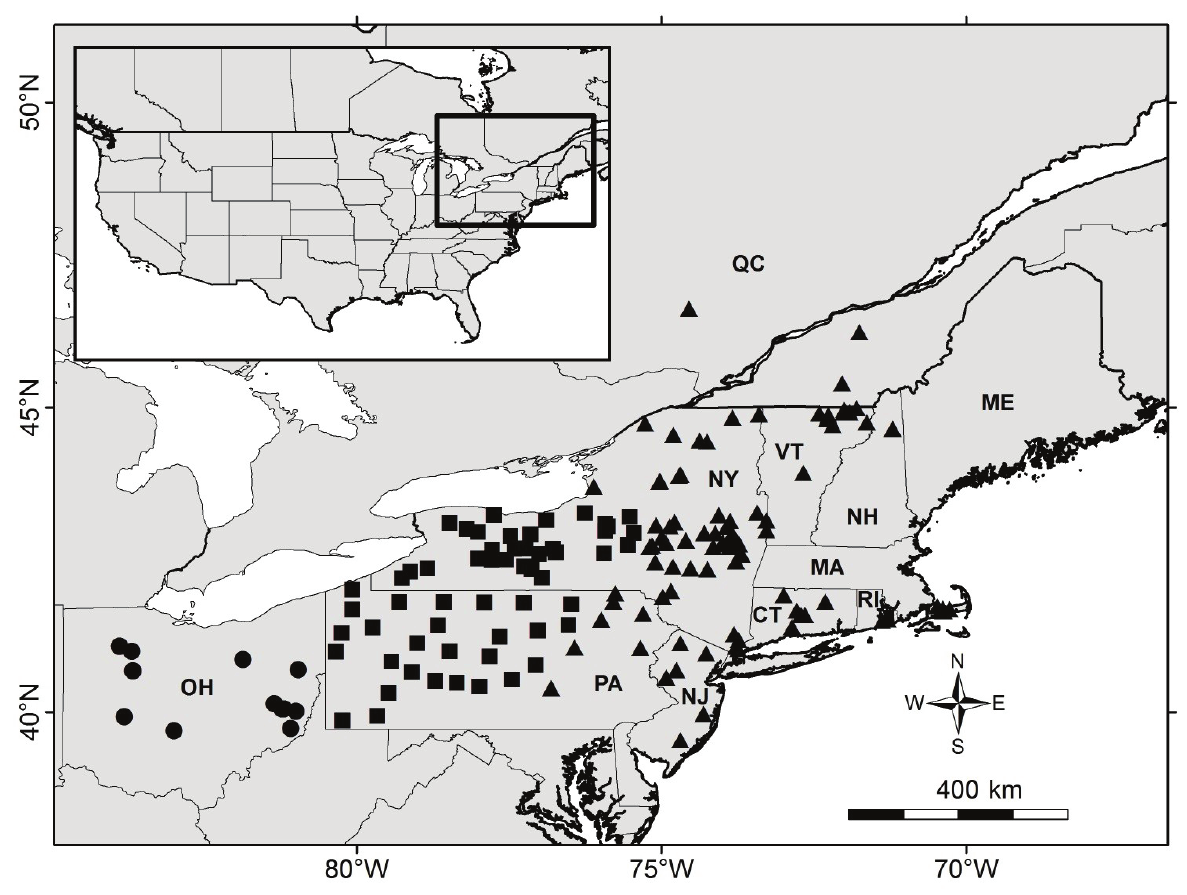
Figure 1. Study area and sampling localities of 385 coyotes from northeastern United States and southeastern Canada. Symbol shapes represent phylogeographic zones as in Kays et al. 5 : circle, Ohio; square, contact zone; triangle, northeast